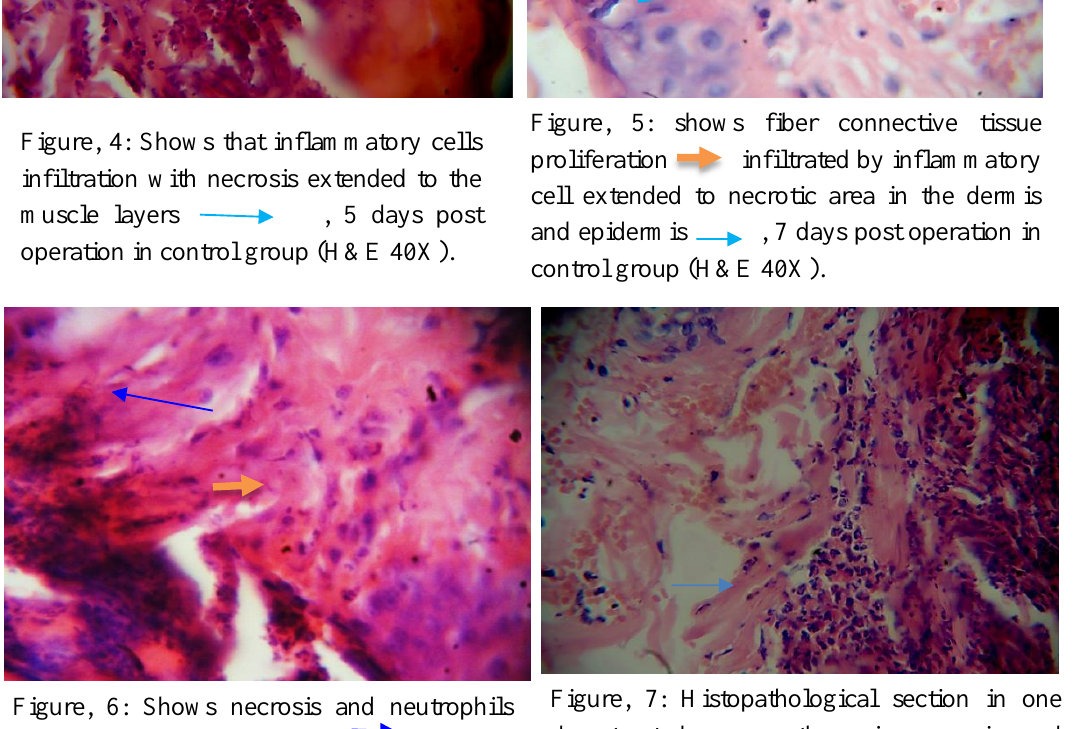
Figure, 6: Shows necrosis and neutrophils infiltration in the dermis and the inflammatory cell present in the muscular layers , 14 days post operation in control group (H&E40X).